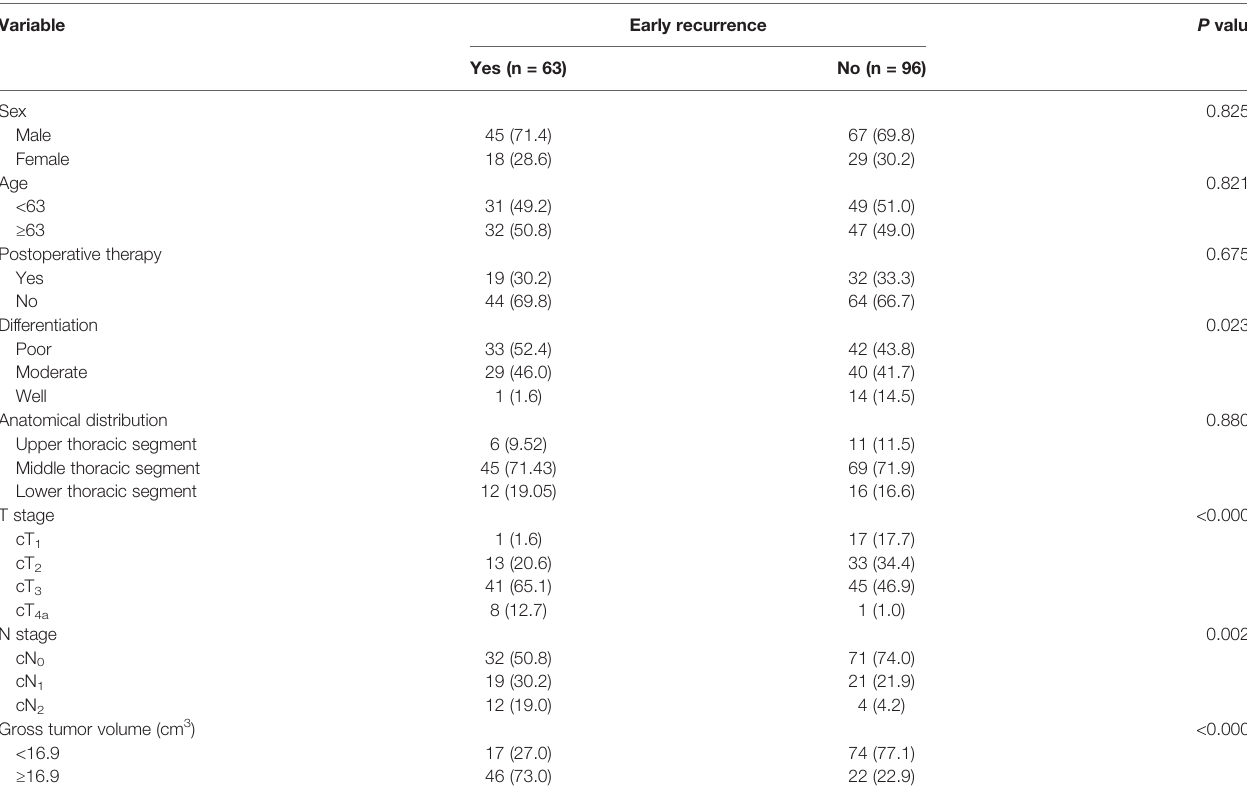
TABLE 2 | Univariate analysis of clinicopathological factors and gross tumor volume correlated with early recurrence in the training cohort.